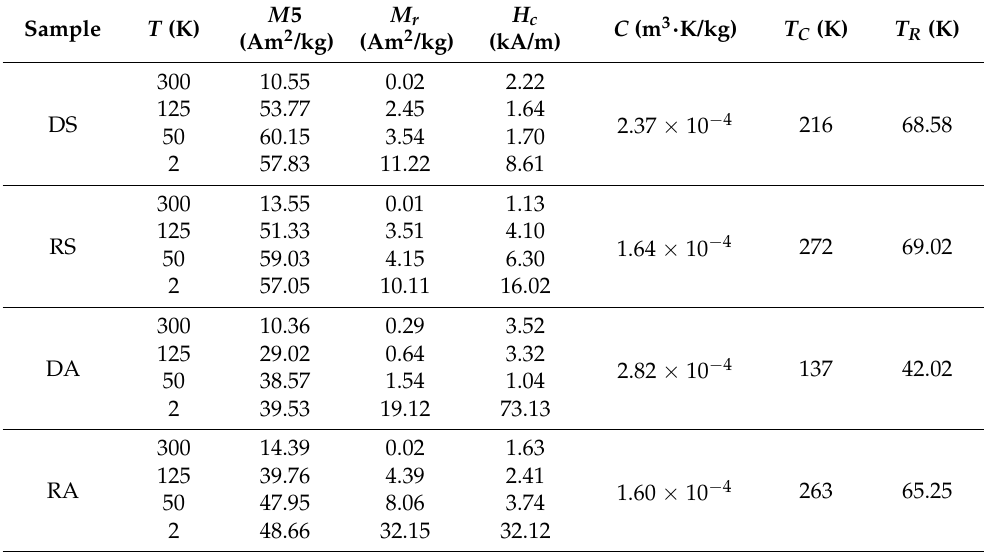
Figure 8. Hysteresis loops of Fe 2 MnSi ( a , DS; b , RS: top panels) and Fe 2 MnAl ( c , DA; d , RA: bottom panels) alloys measured at constant temperatures T = 2 K, 50 K, 125 K, and 300 K. The inset in bottom panel ( c ) presents detail of hysteresis loop at 300 K. Table 4. Magnetic parameters of Fe 2 MnSi (DS, RS) and Fe 2 MnAl (DA, RA) alloys determined from hysteresis loops (magnetization at 5 T, M 5; remnant magnetization, M r ; coercivity, H c ), by applying the Curie-Weiss law (Curie constant, C; Curie temperature, T C ), and from a maximum on zero-field-cooled (ZFC) curve (temperature of re-orientation, T R